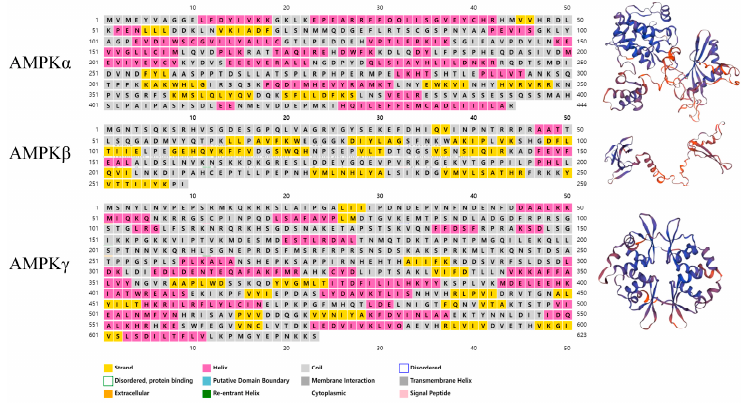
Figure 4. The predicted secondary and tertiary structure of McAMPK.